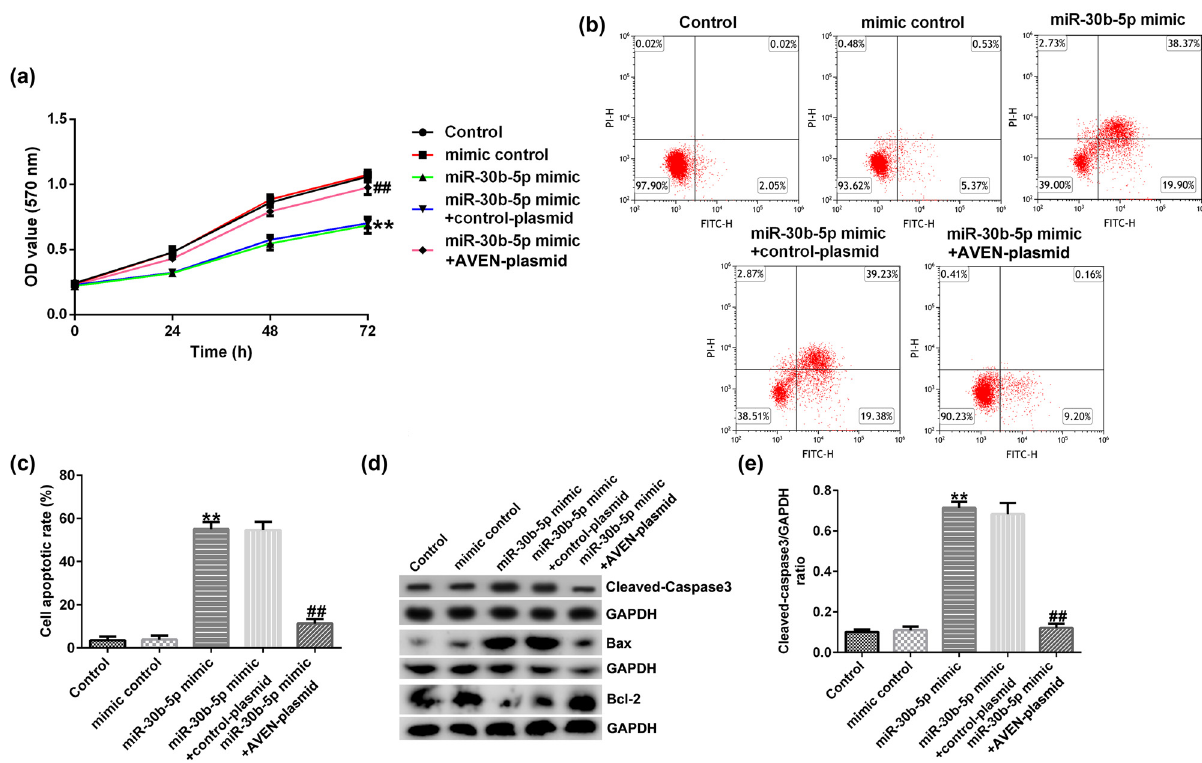
Figure 4: miR - 30b - 5p overexpression inhibits proliferation and promotes apoptosis in SW480/R via AVEN. ( a ) MTT assay was carried out to assess SW480/R cells viability. ( b and c ) FCM assay was carried to measure SW480/R cell apoptosis. ( d ) Western blot was used to quantify the expression levels of apoptosis - related protein ( cleaved - caspase3, Bax, and Bcl - 2 ) . ( e ) The ratio of cleaved - caspase3/GAPDH. Data are represented as the mean value ± SD of three independent experiments. ** P < 0.01 vs Mimic control; ## P < 0.01 vs miR - 30b - 5p mimic + control - plasmid.